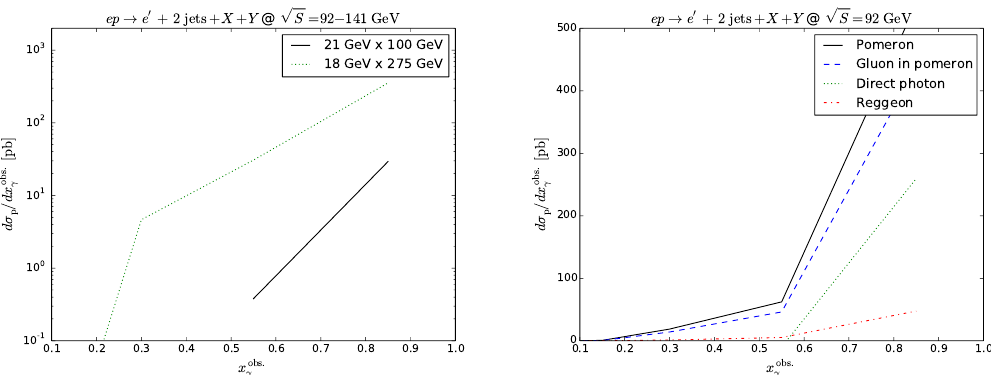
Figure 3: Distributions in the observed photon momentum fraction x obs. GeV × 275 GeV and 21 GeV × 100 GeV beam configurations (left) and with a higher < 0.10 cut on x IP